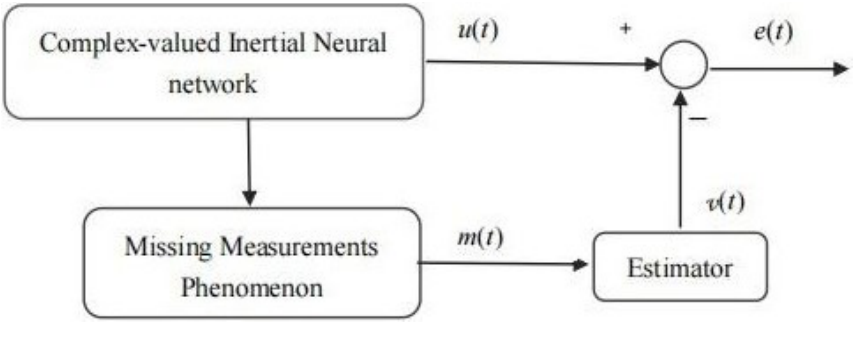
Figure 1. Flow chart of the